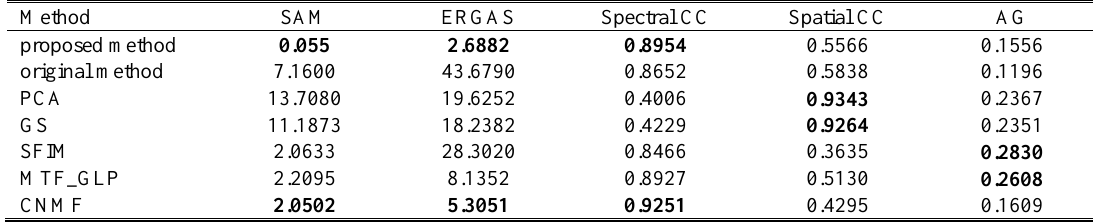
Table 3. Evaluation indexes of dataset